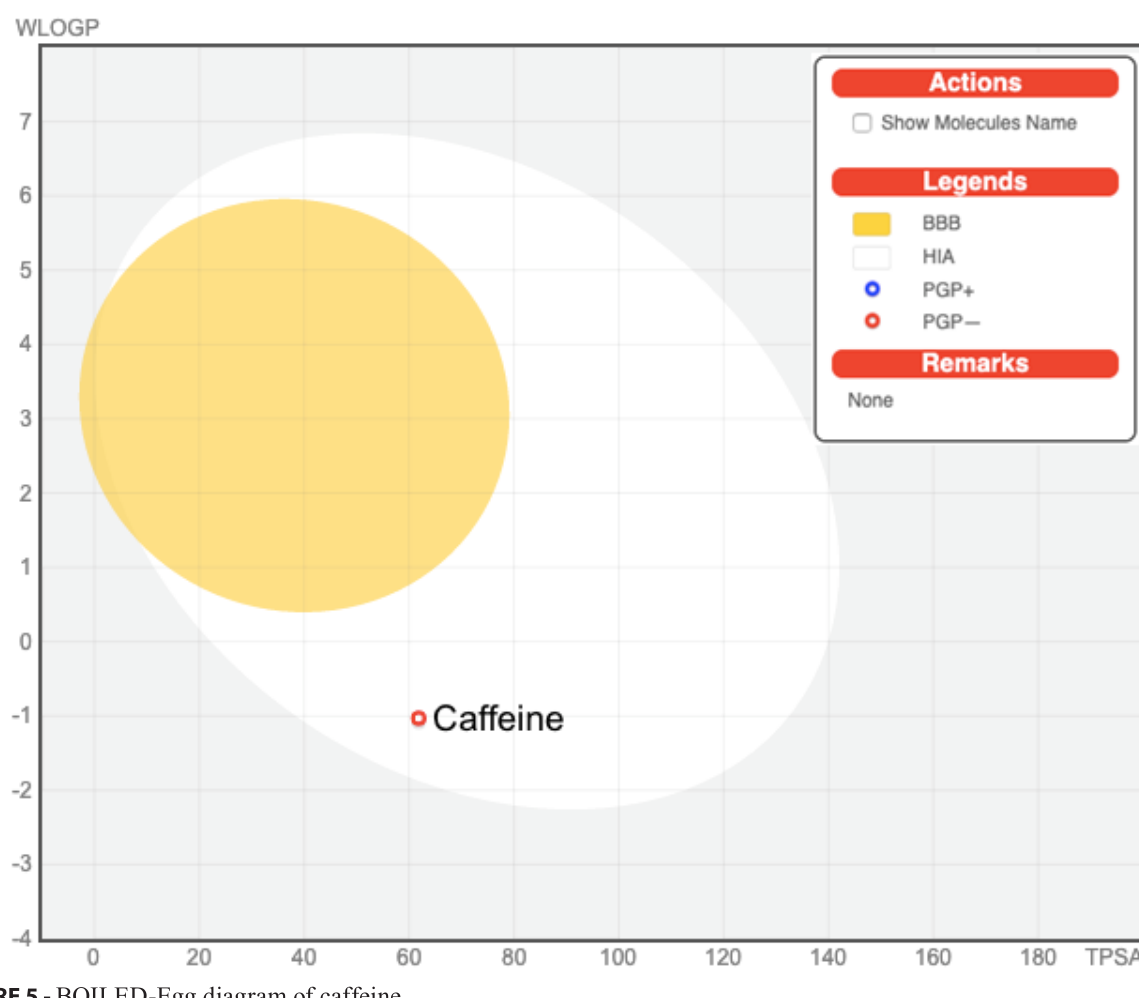
FIGURE 5 - BOILED-Egg diagram of